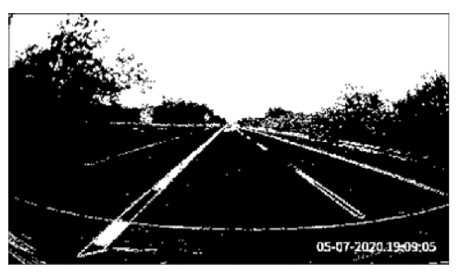
Figure 3. Final output,